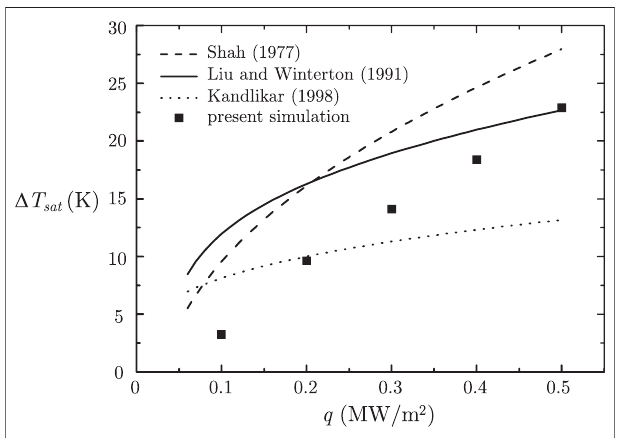
FIGURE 11 | Heat transfer coef fi cient under various heat fl